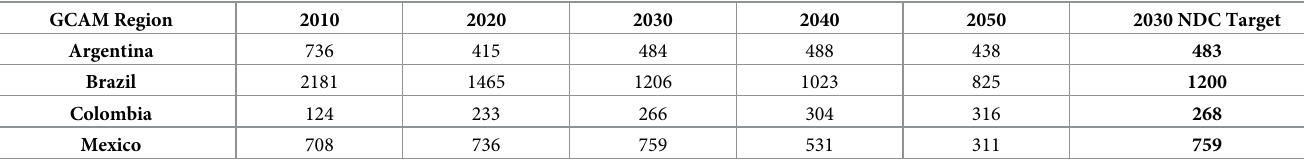
Table 1. Regional Net GHG emissions (MtCO2 e ) in the NDC_FullTech scenario a . GCAM